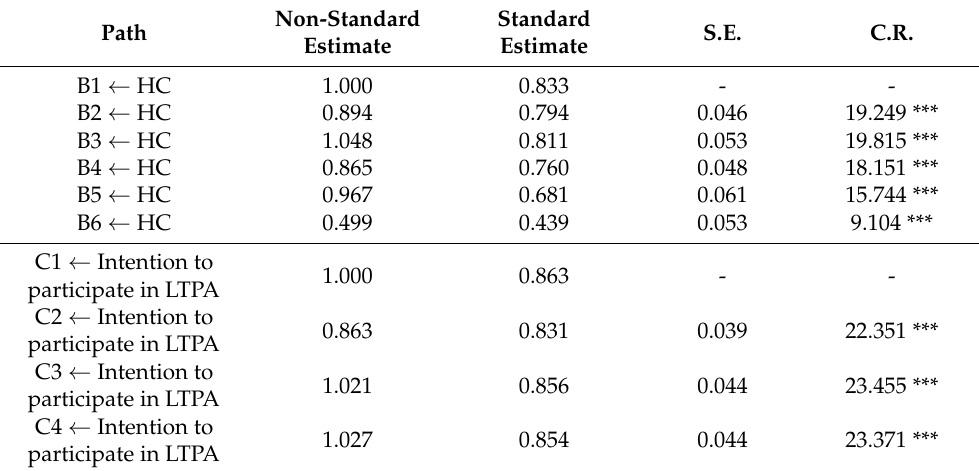
Figure 1. Confirmatory factor analysis showing the suitability of HC and intention to participate in LTPA. Numbers describe the relationship between factors. The reliability values of HC and intention to participate in LTPA are detailed in Table 3. Table 3. Confirmatory factor analysis of HC and intention to participate in LTPA.